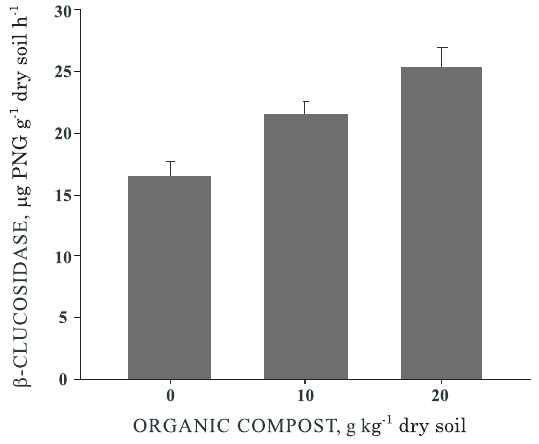
Figure 3. ββ ββ β -glucosidase activity due to compost amendment in Acrustox soil due to compost amendment in Acrustox soil. PNG: ρρρρρ -nitrophenol glucoside. Vertical bars indicate average confidence intervals at 5% probability